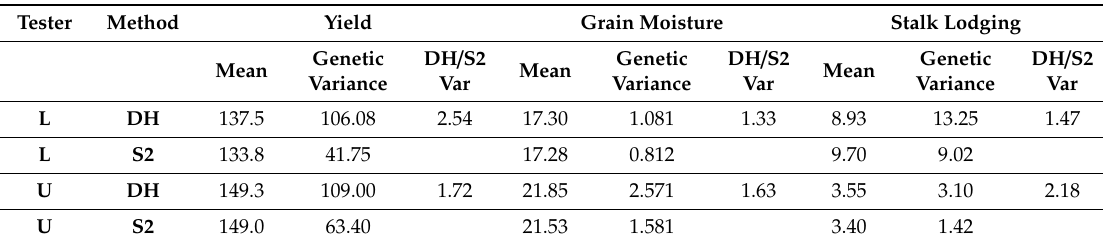
Table 1. Averages and genetic variance estimates for yield, grain moisture, and percent stalk lodging for each tester and both methods of line